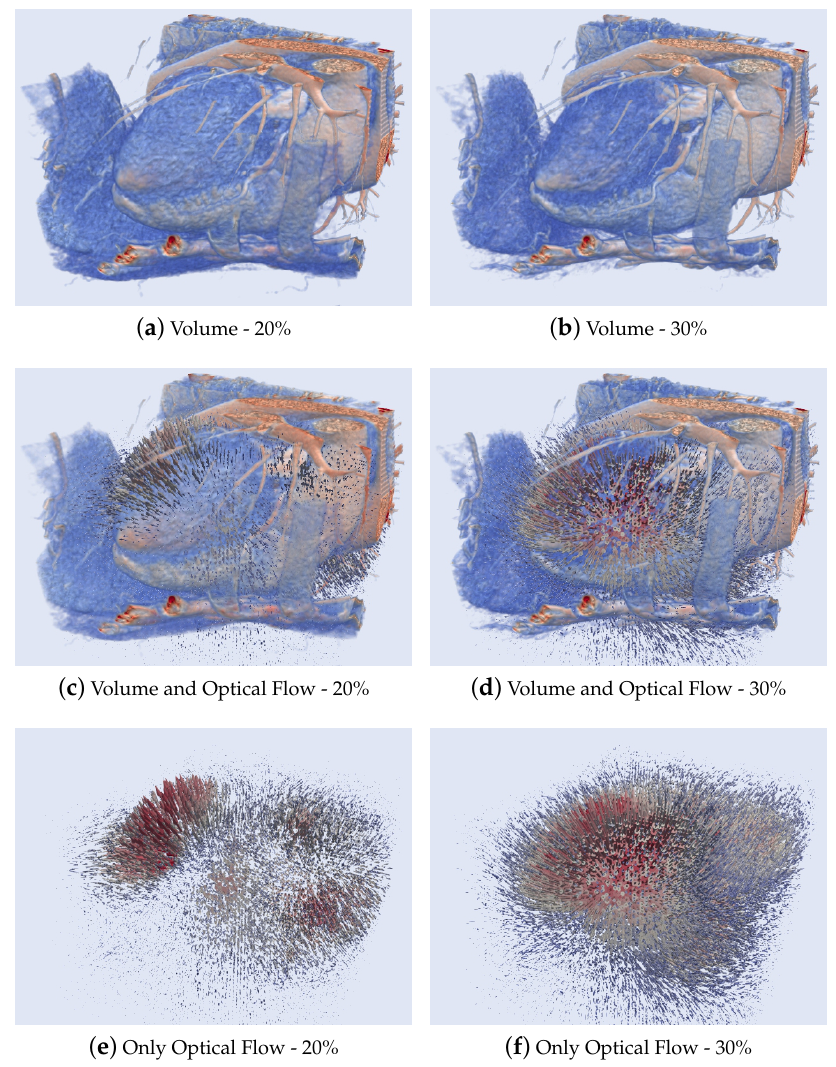
Figure 14. Results of 3D Optical Flow of a segmented cardiac CT volume computed at phases